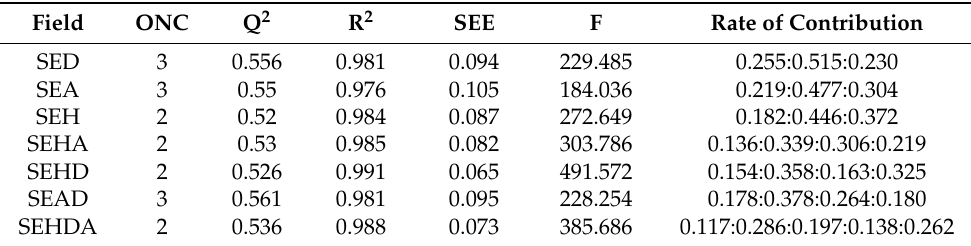
Table 4. Different field combinations in CoMSIA analysis for alignment-B.